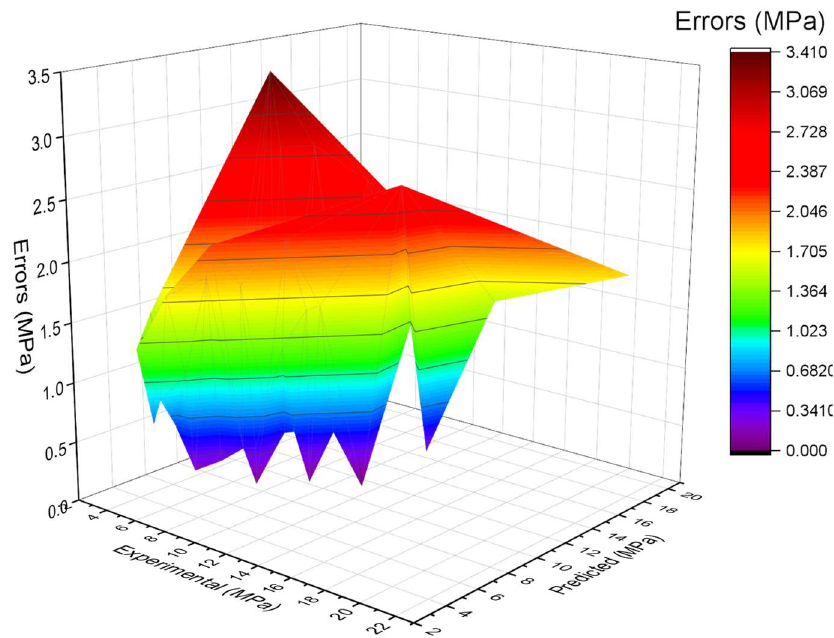
Figure 5. Estimated AdaBoost and experimental values, with errors.